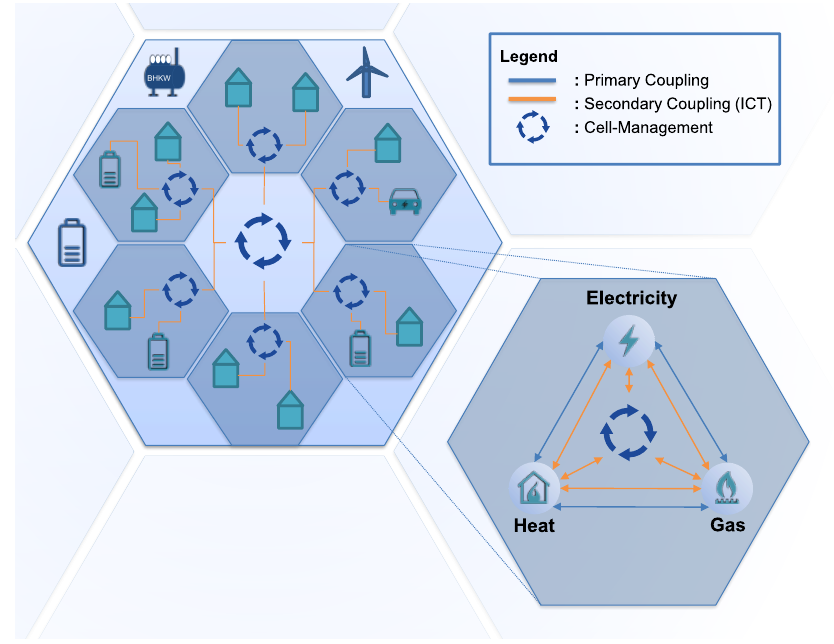
Figure 2. Cellular energy